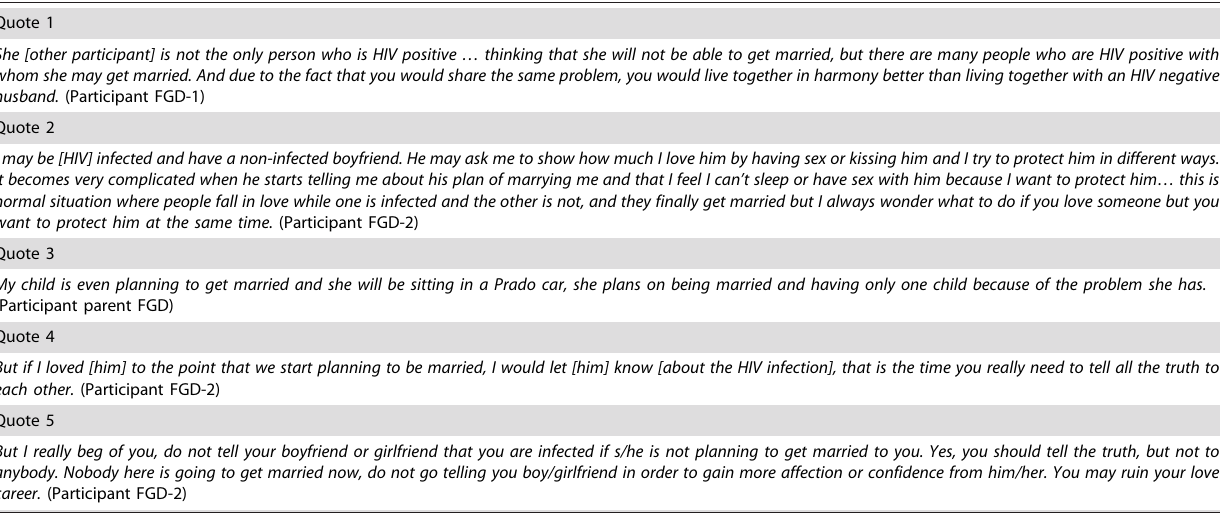
Table 2. Quotes regarding HIV and